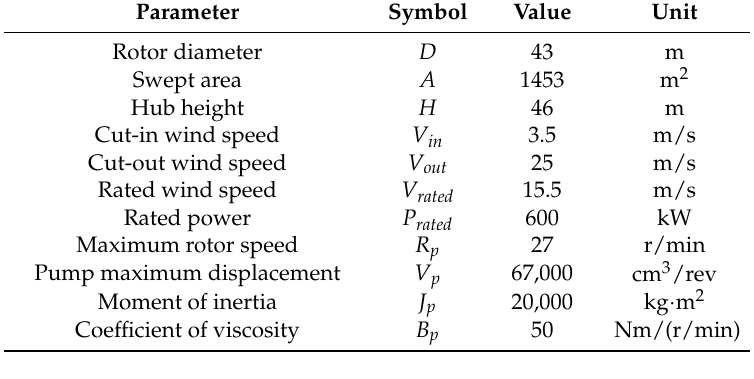
Table 1. Main parameters of wind turbine and hydraulic pump.